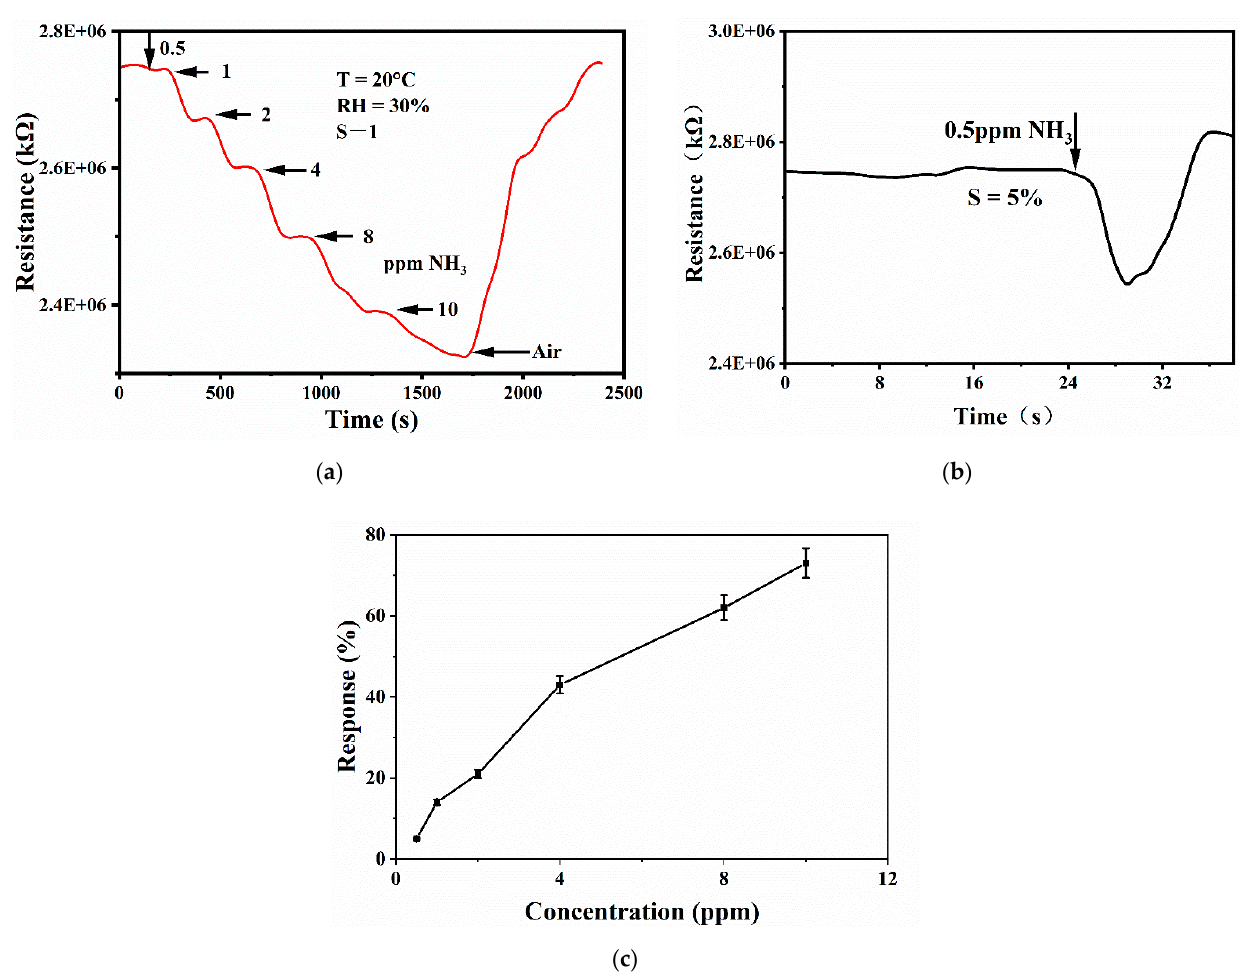
Figure 6. ( a ) Response curve of S-1 to gradient concentrations of ammonia, ( b ) detection limit test of S-1 to ammonia, and ( c ) sensitivity curve of S-1 to different concentrations of ammonia.